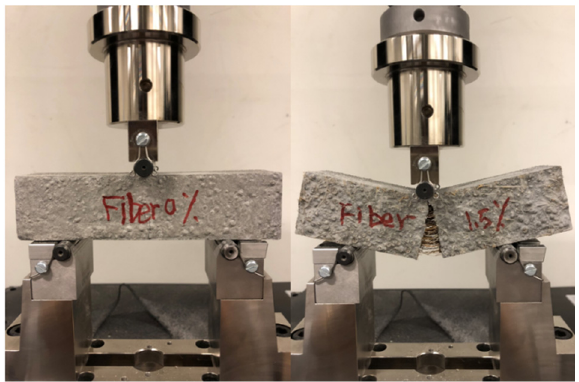
Figure 15. Flexural fracture characteristic of LWAC. The left sample without coir fibers and the right one with 1.5% coir fibers.